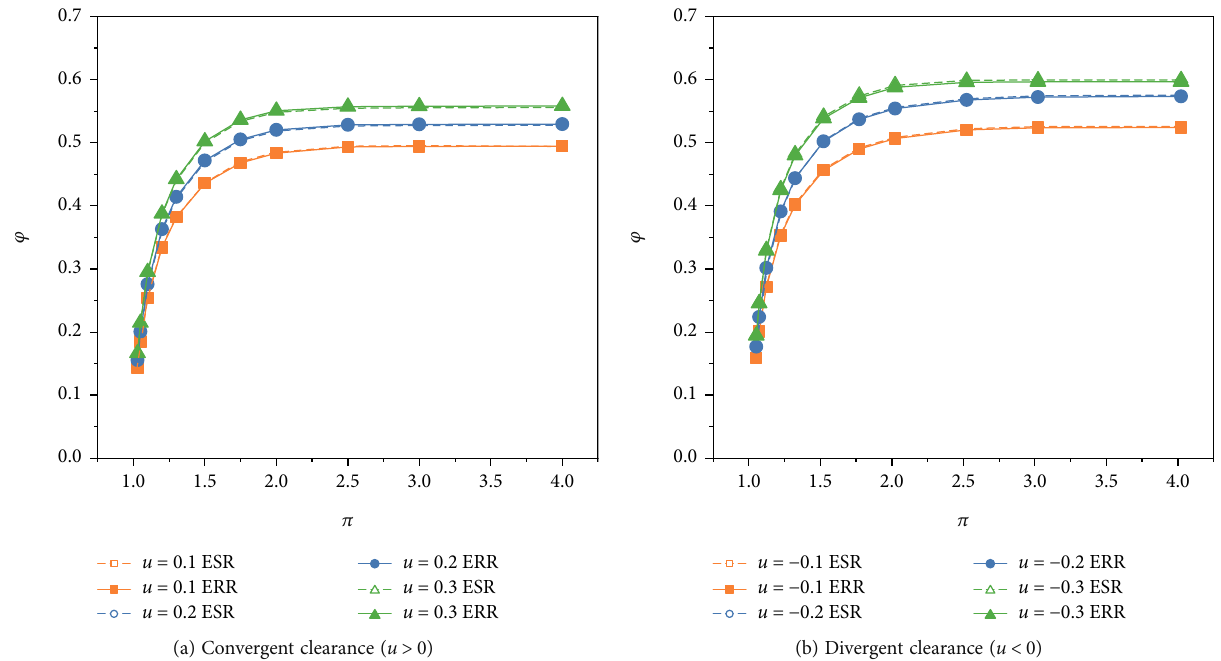
= 0 : 23 , and C = 0 : 067 ). U